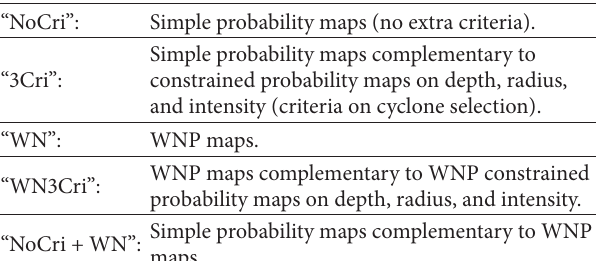
Table 1: Types of probability